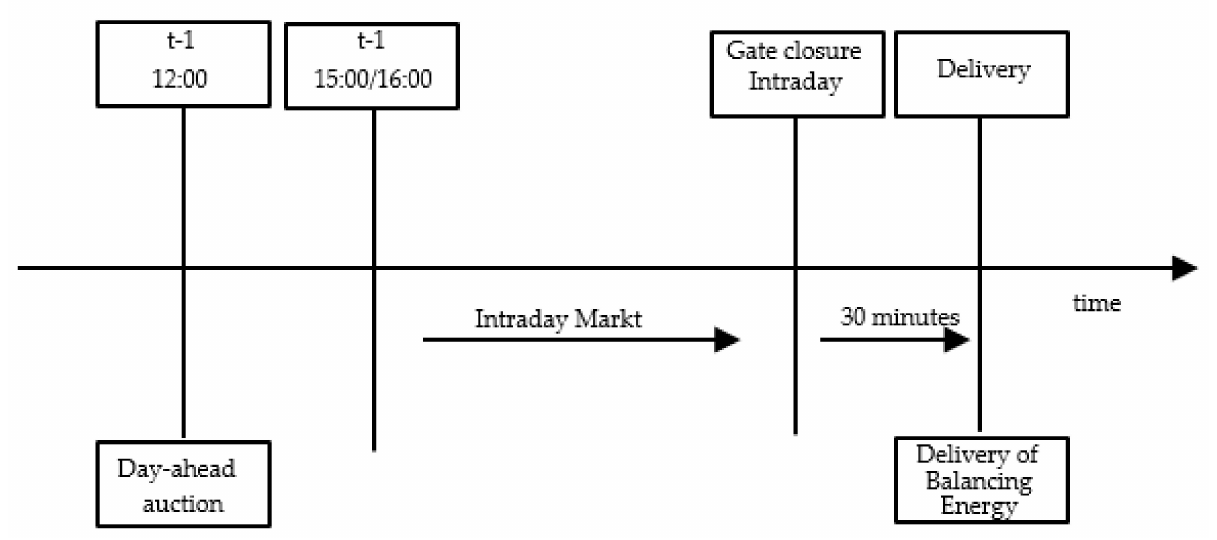
Figure 1. This figure represents the German electricity spot market. This figure functions to improve understanding on the market design. This figure has been presented according to Kramer and Kiesel (2021)